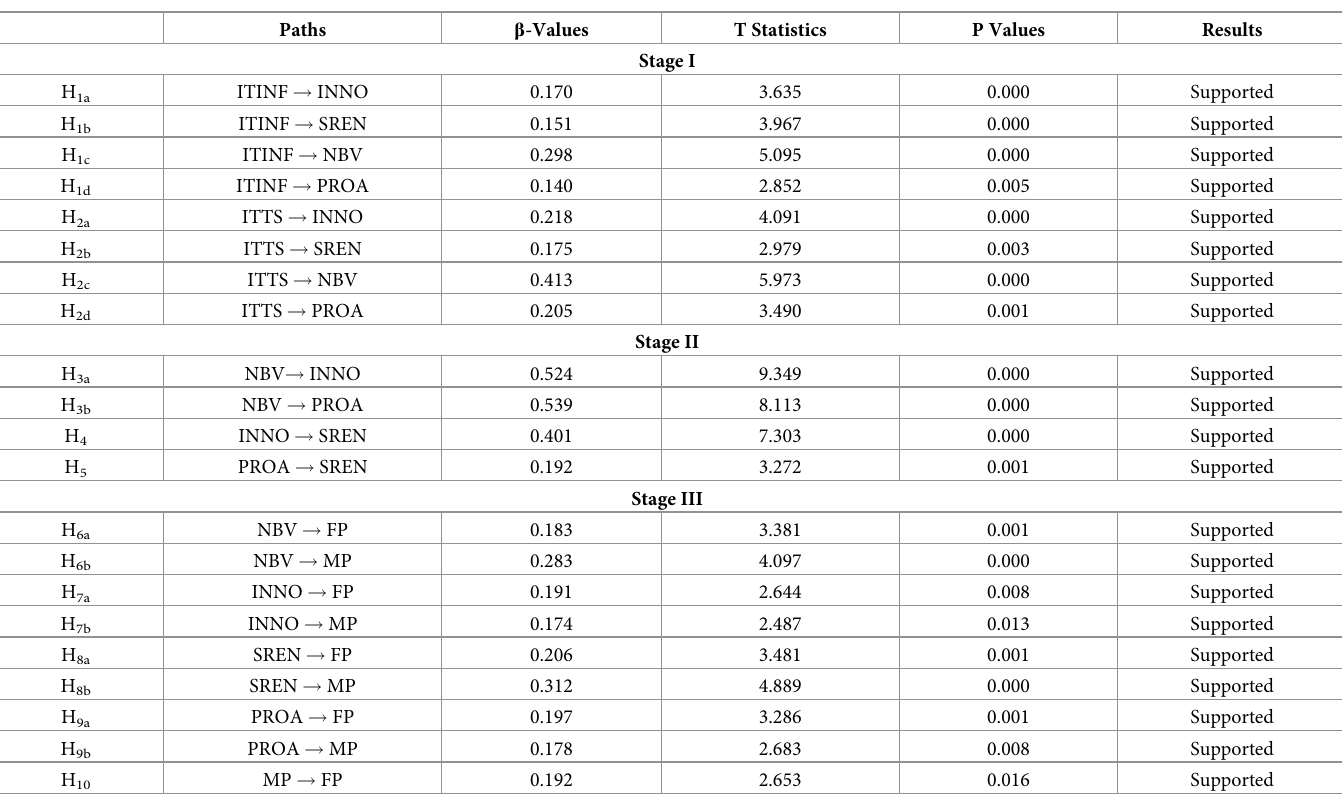
Table 6. Path coefficient.